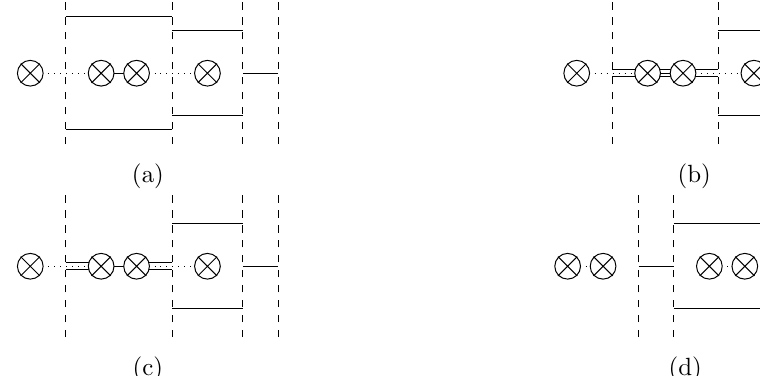
~l ~l d = (3 ; 3 ; 3 ; 3), s = (1 ; 1 ; 1 ; 1)